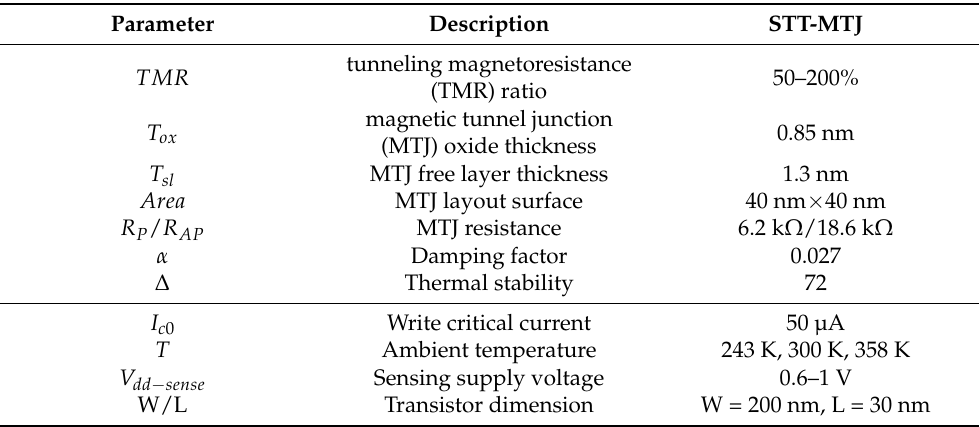
Table 1. Physical properties and design parameters of spin-transfer torque-magnetic tunnel junction